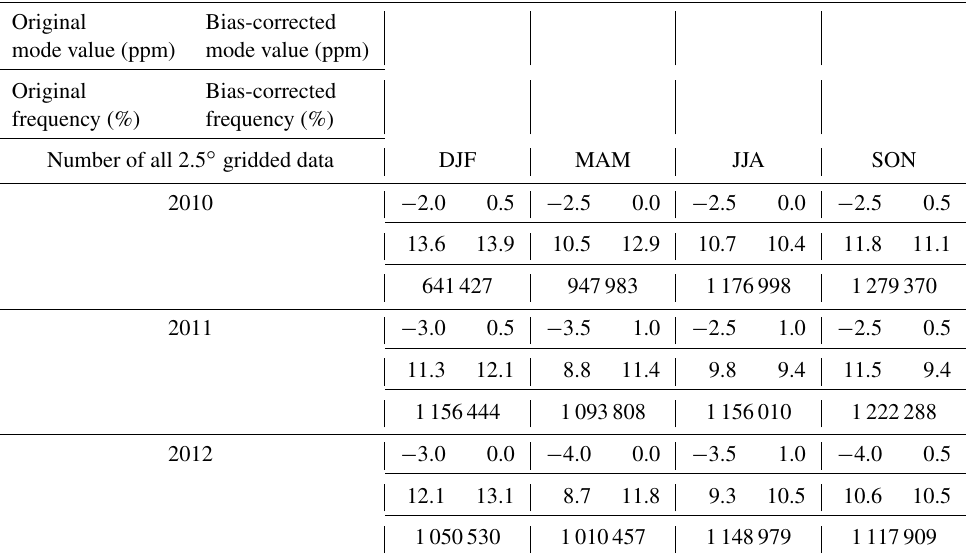
Table 3. Mode values of frequency distributions of differences in monthly averaged CO 2 concentrations between original (top left boxes) or bias-corrected (top right boxes) GOSAT/TANSO-FTS TIR and NICAM-TM CO 2 data in each season of 2010–2012, shown in Fig. 7. The mode values presented here indicate the center value of a bin with a width of 0.5ppm; a bin of “0.0” ranges from − 0.25 to + 0.25ppm. Ratios of numbers of data categorized into each of the mode values to numbers of all 2.5 ◦ gridded data for comparisons (bottom boxes) are shown in middle left (original) and right (bias-corrected)